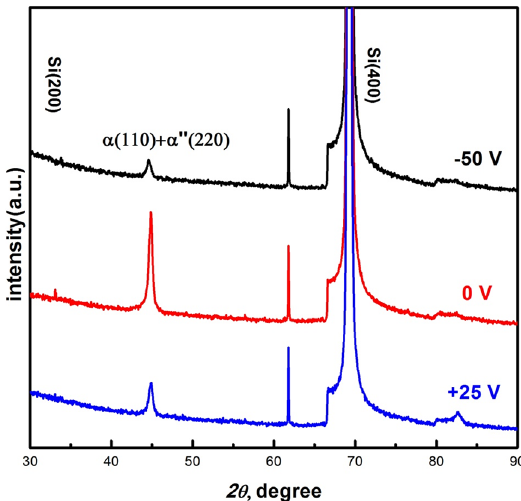
Table 2. Average grain size of α-Fe and α ’’ –Fe the Scherer formula.